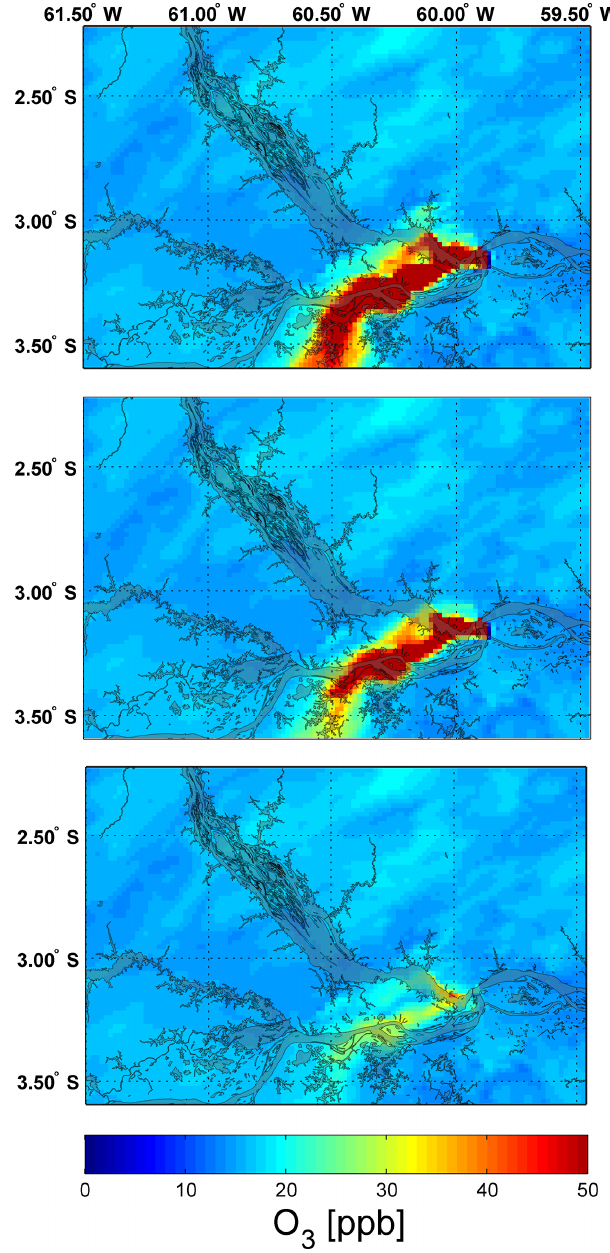
Figure 3. Maps of near-surface ozone concentrations for historical emissions (case A), present-day emissions (case B), and planned future emissions (case C). Ozone concentrations correspond to 15:00 (local time) near the surface for the meteorology of 1 Febru- ary 2014. The local river system is shown in the background. The black box, centered over the population center of Manaus, repre- sents the averaging area used in the box-and-whisker plots of Figs. 2 and